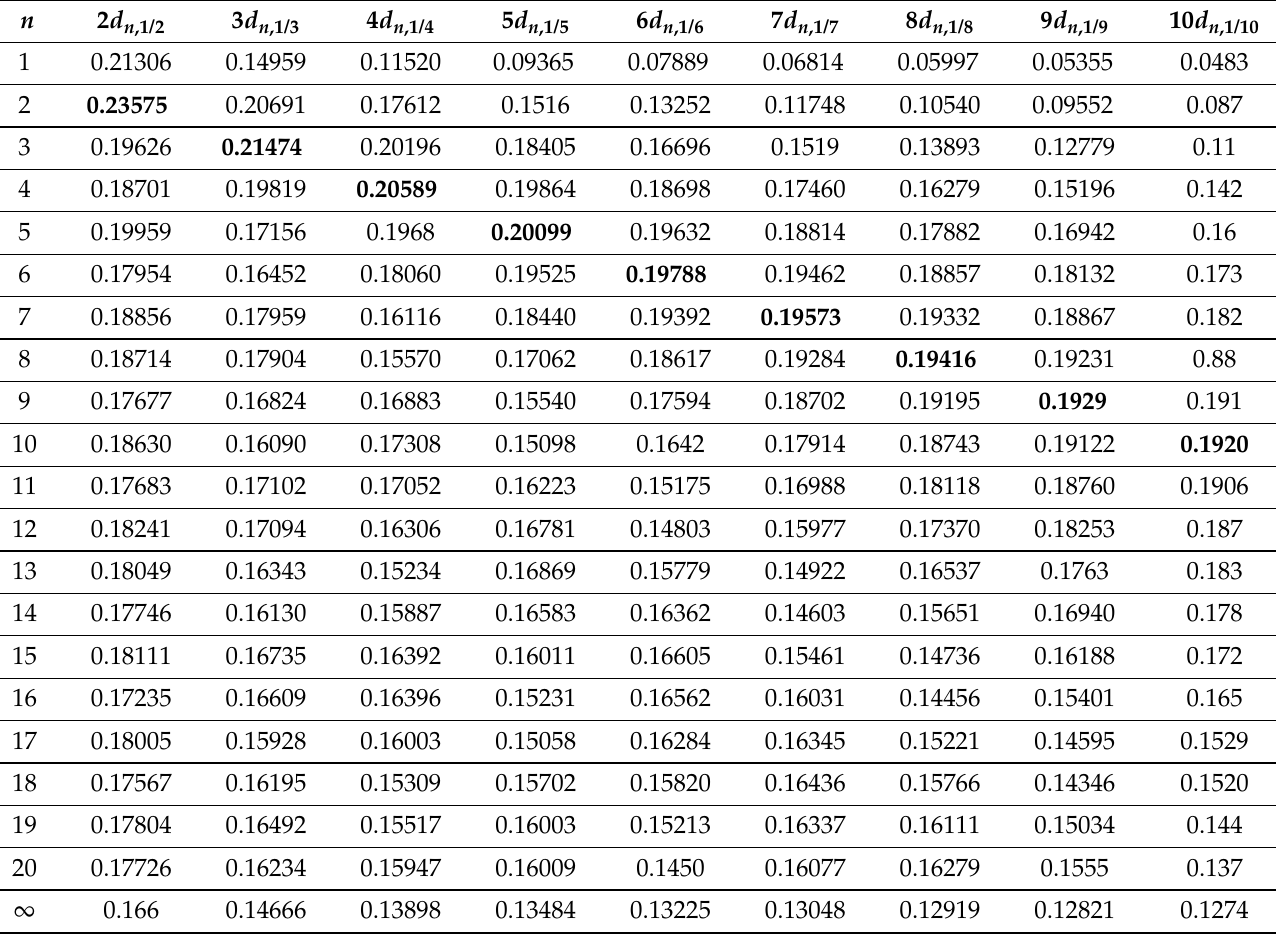
Table 6. Values of product k d n ,1/ k for k = 2,10, n =